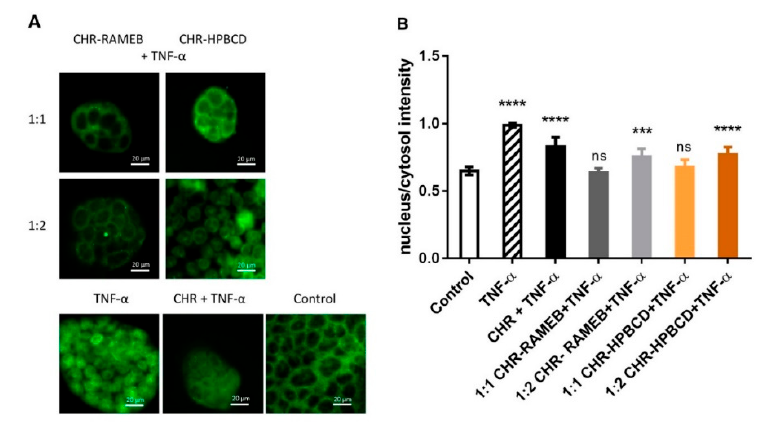
Figure 4. Immunohistochemical staining and analysis of NF- κ B activation in CHR or CHR–CD complex-pretreated and TNF- α stimulated Caco-2 cells. ( A ) Caco-2 cells were pretreated with CHR or CHR–CD complexes and stimulated with TNF- α . Control cells were kept in culture medium. Nuclear localization of the NF- κ B p65 subunit was monitored by immunostaining. Cell nuclei were labeled with Hoechst 33,342. Green: p65 staining; blue: cell nuclei. Scale bar: 20 µ m. ( B ) Ratio of the fluorescence intensity of the NF- κ B immunostaining in cell nuclei and cytoplasm. Values were expressed as means ± S.D., n = 8–10, **** p < 0.0001, *** p < 0.001, the values were compared to the value of untreated control.